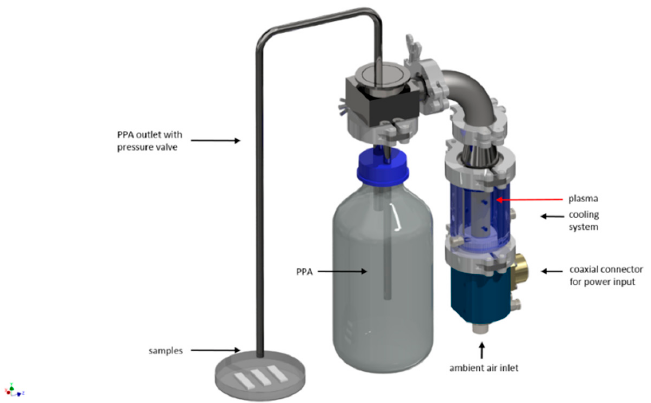
Figure 1. Scheme of the microwave-setup for the generation of PPA (plasma-processed air) (Baeva et al., 2014 [29], Krohmann et al., 2005